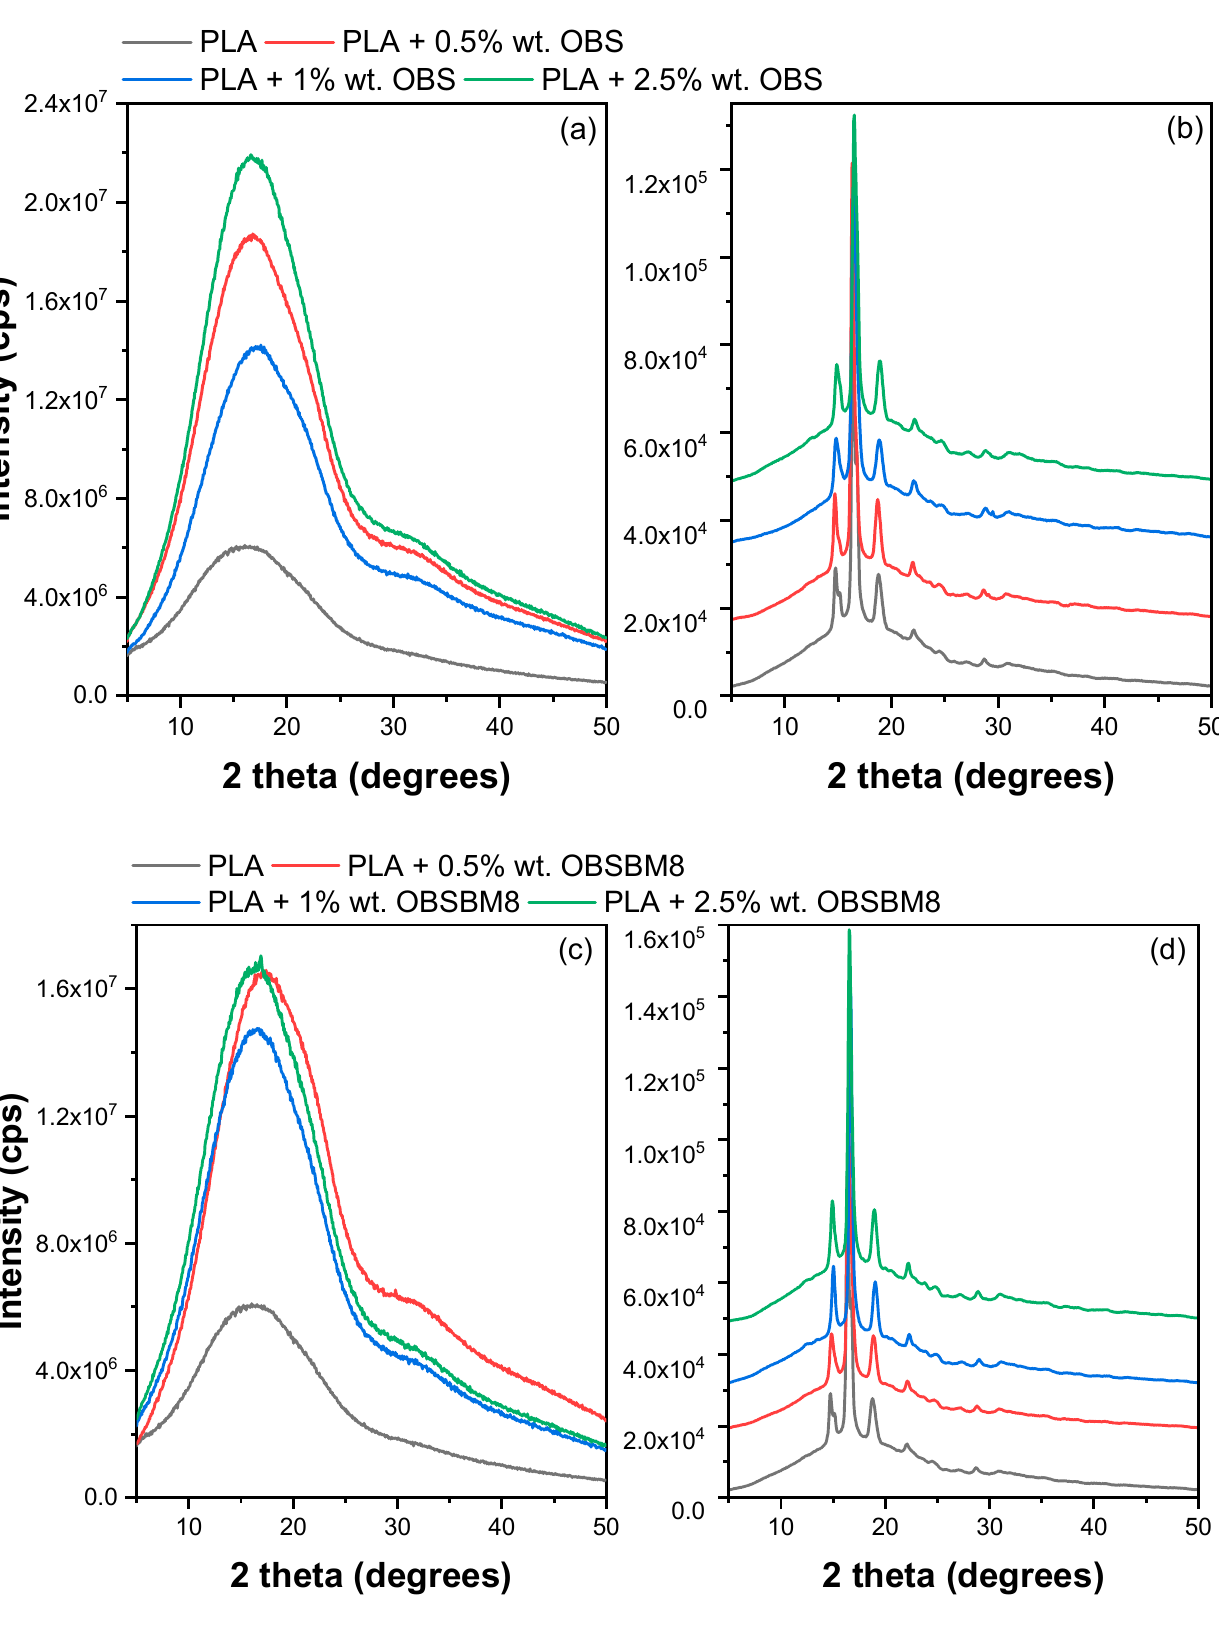
Figure 7. XRD patterns of ( a , b ) PLA/OBS and ( c , d ) PLA/OBSBM8 samples after quenching and after annealing at 110 °C for 1 h.